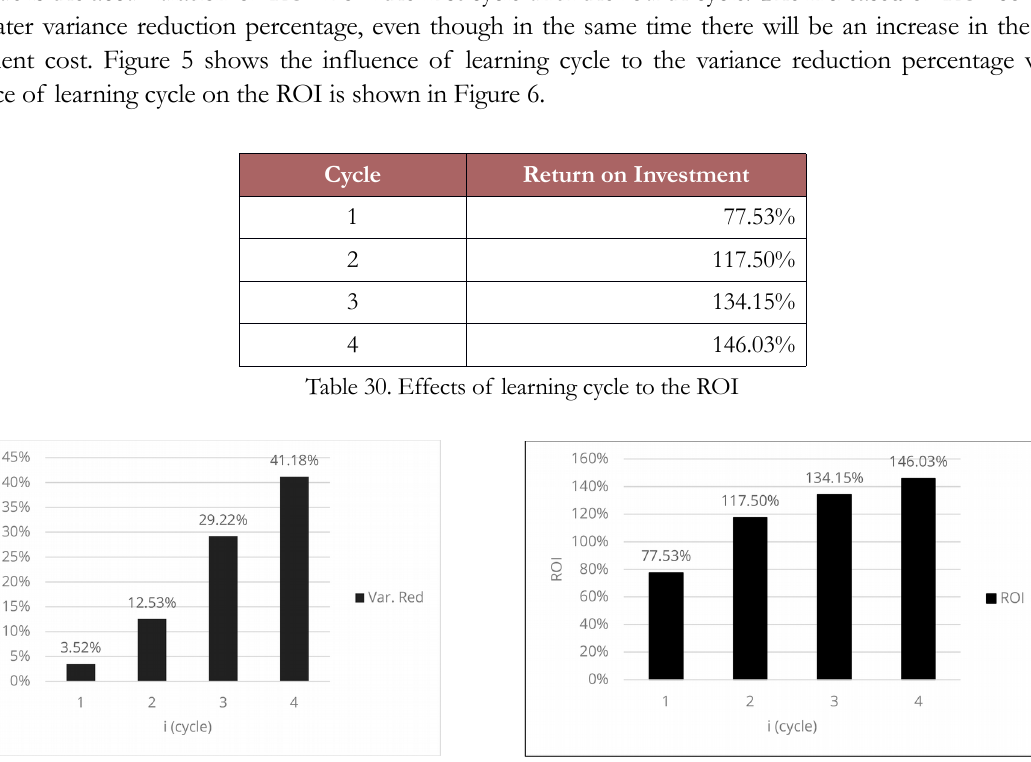
Figure 5. Effect of learning cycle to the Variance Reduction Figure 6. Effects of learning cycle to the